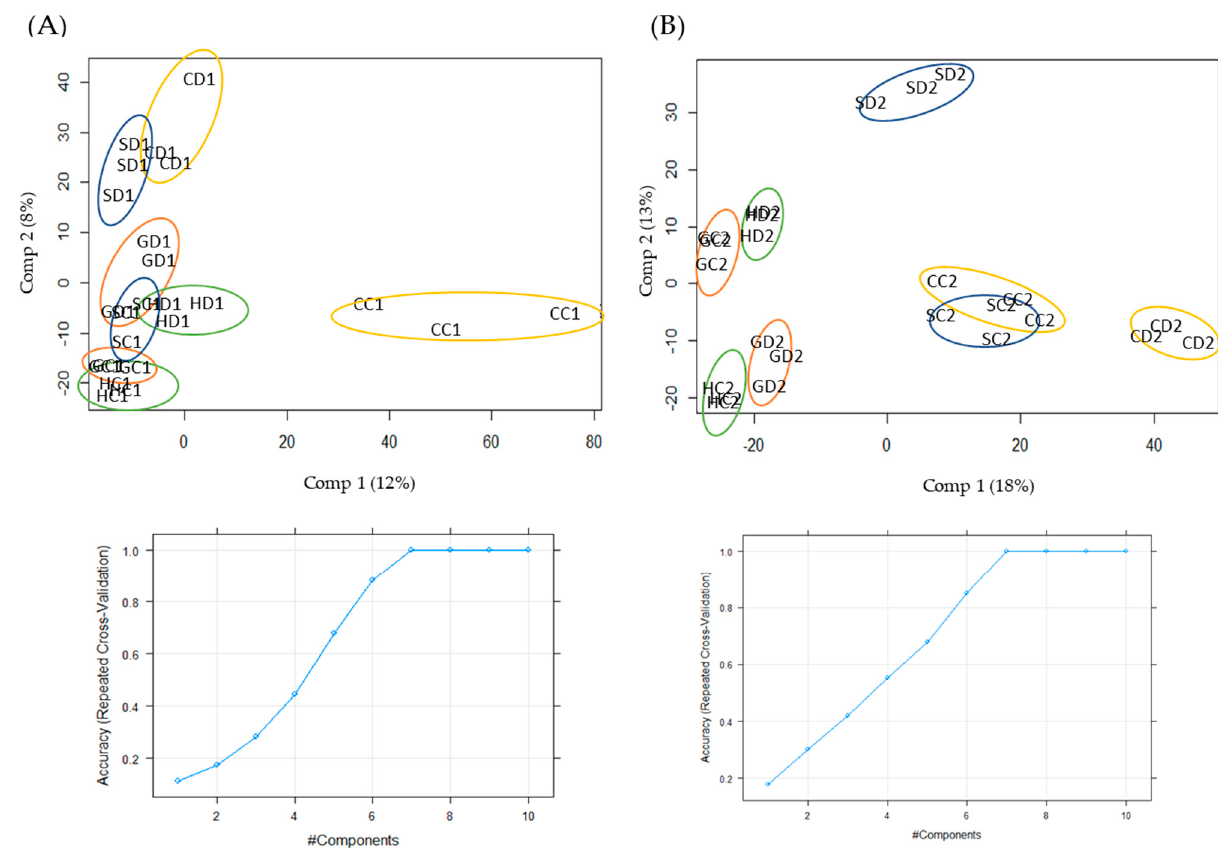
Figure 2. Partial least-squares discriminant analysis (PLS) of the entire dataset after 17 ( A ) and 24 days of drought ( B ) is shown in the upper part. The cumulative proportion of variance explained by components is shown below. C, Cadiz; G, Granada; H, Huelva; S, Seville. The letters following C, G, H, or S denote treatment (D, drought; C, control), the numbers before the underscore sampling time (1, 17 days; 2, 24 days) and that after it replicates (1, 2 or 3).